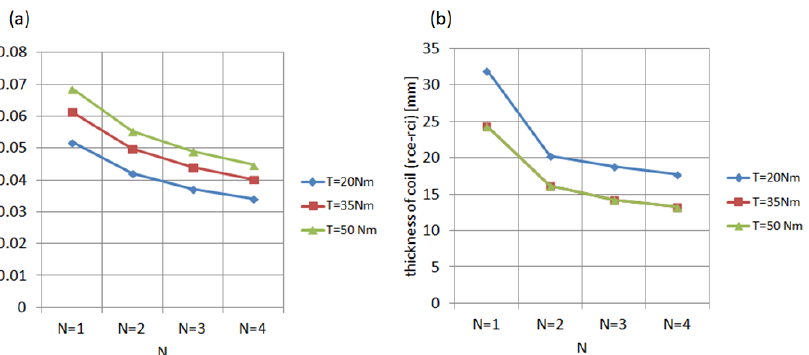
Figure 7. Drop in internal radius of excitation coil and in its thickness: ( a ) internal radius of excitation coil r ci vs. number of discs N; ( b ) thickness of excitation coil ( r ce